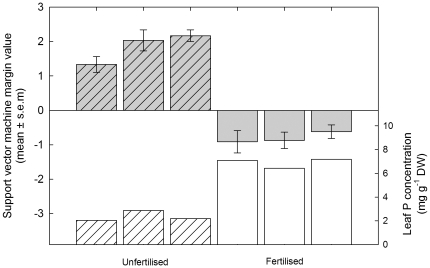
Class prediction for Pi status of Pi fertilised and unfertilised field grown potato plants.Margin values from Support Vector Machine (SVM) analysis of transcriptional profiles of field grown potato plants supplied with (fertilised; plain bars) or without (unfertilised; diagonal lined bars) Pi fertiliser applications (left axis) and the leaf P concentration of potato leaf samples from the same plants (right axis). Margin values are means ± SEM (n = 5).